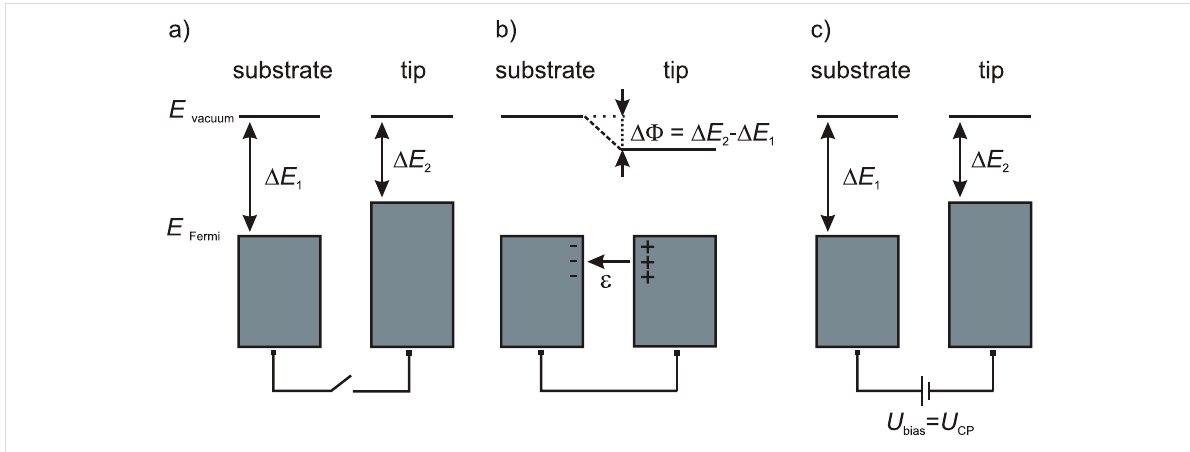
Figure 4: Energetic levels. a) The Fermi levels of tip and sample when they are not electrically connected. b) Tip and sample are electrically connected and the Fermi levels align resulting in an electrostatic field. c) If the sample bias voltage corresponds the contact potential, i.e., U CP = ΔΦ / e , the electrostatic field is